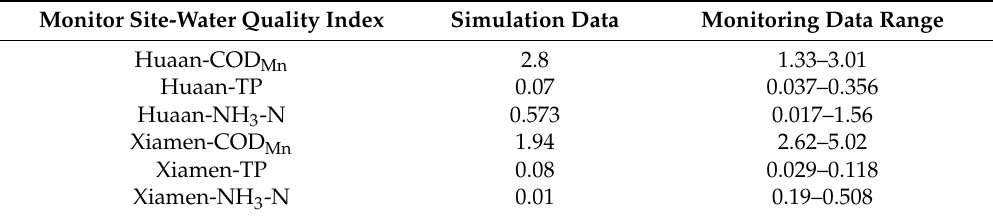
Table 15. The verification table of simulated water quality